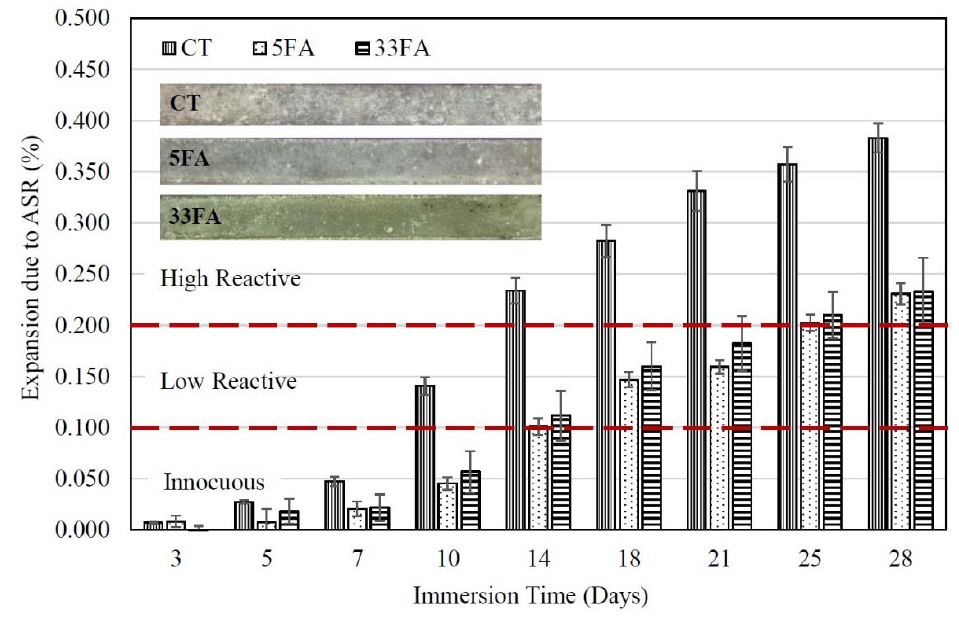
Figure 4. Relationship between the ASR expansion of 5FA and 33FA mortars and immersion time. The ASR expansions of mortars containing 5FA and 33FA is presented in Figure 4. Mor- tars containing either 5FA or 33FA at 20% had ASR expansions that were lower than the CT mortar. The 5FA and 33FA mortars had expansions of 0.101 ± 0.008% and 0.112 ±